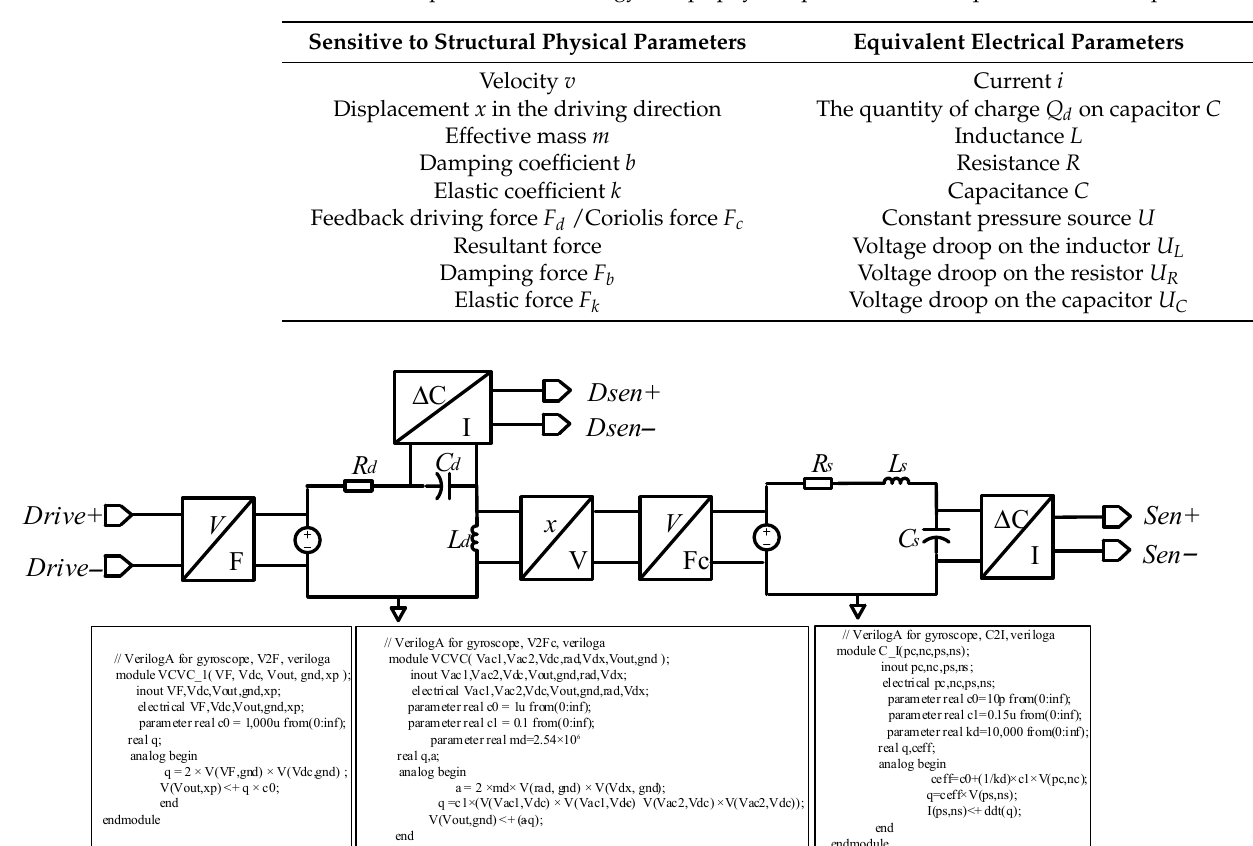
Figure 4. Equivalent electrical model of mechanically sensitive structure of gyroscope.